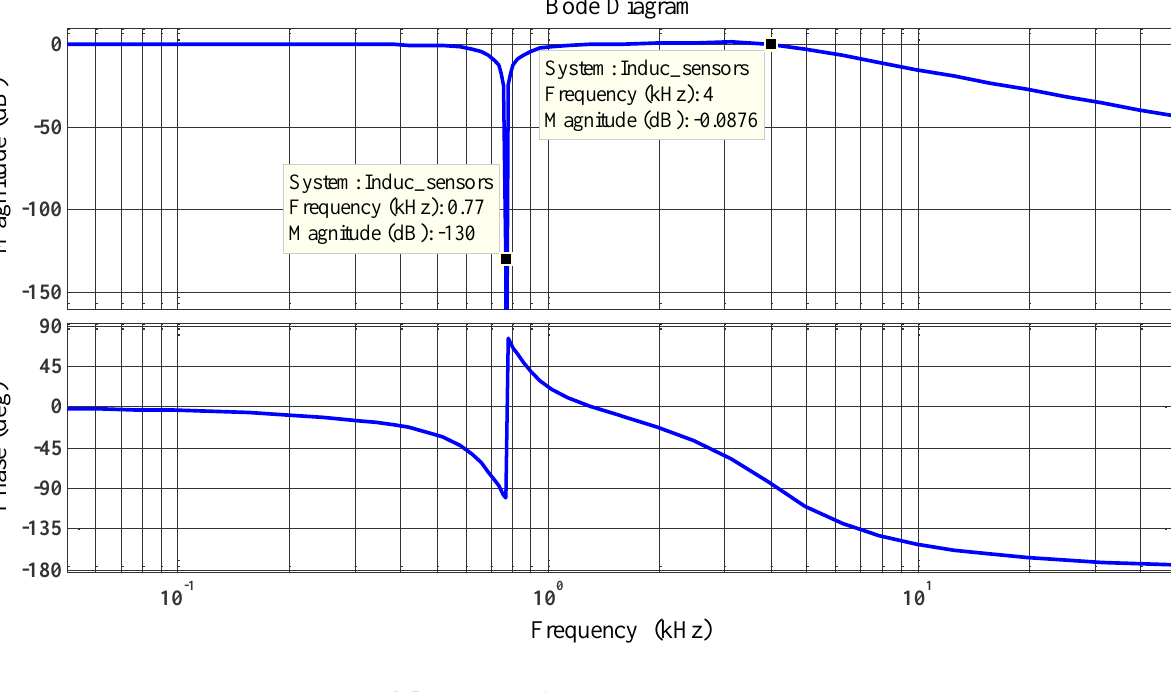
Table 4. Specification test rig